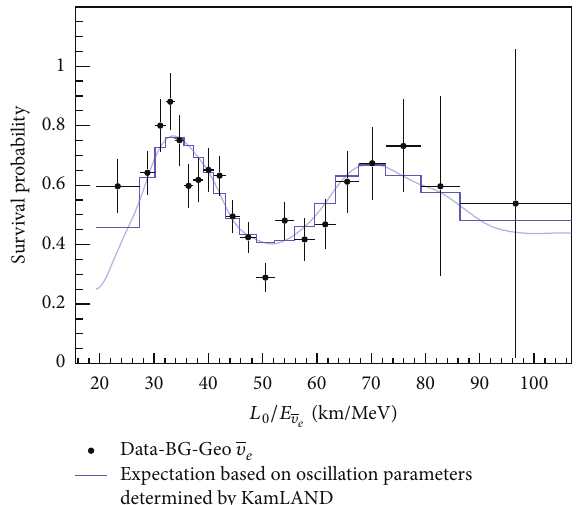
Figure 6: Ratio of the background and geo-neutrino-subtracted 𝜈 𝑒 spectrum to the expectation for no oscillation as a function of /𝐸 . 𝐿 𝐿 0 0 is the effective baseline taken as a flux-weighted average ( 𝐿 0 = 180km). The energy bins are equal probability bins of the best fit including all backgrounds. The histogram and curve show the expectation accounting for the distances to the individual reactors, time-dependent flux variations, and efficiencies. The error bars are statisticalonlyanddonotinclude,forexample,correlatedsystematic uncertainties in the energy scale. Taken from [40].